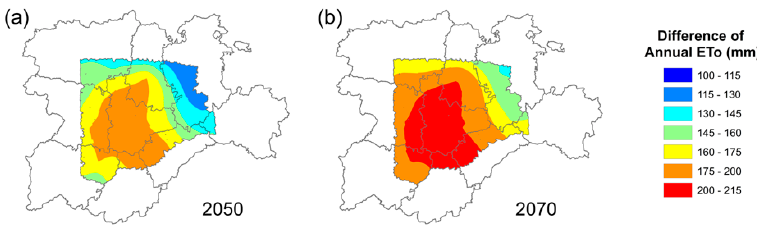
Figure 4. Spatial distribution of differences in annual ET 0 (mm) in the area of the study, for the ( a ) 2050 and ( b ) 2070 scenarios, compared to the baseline scenario.